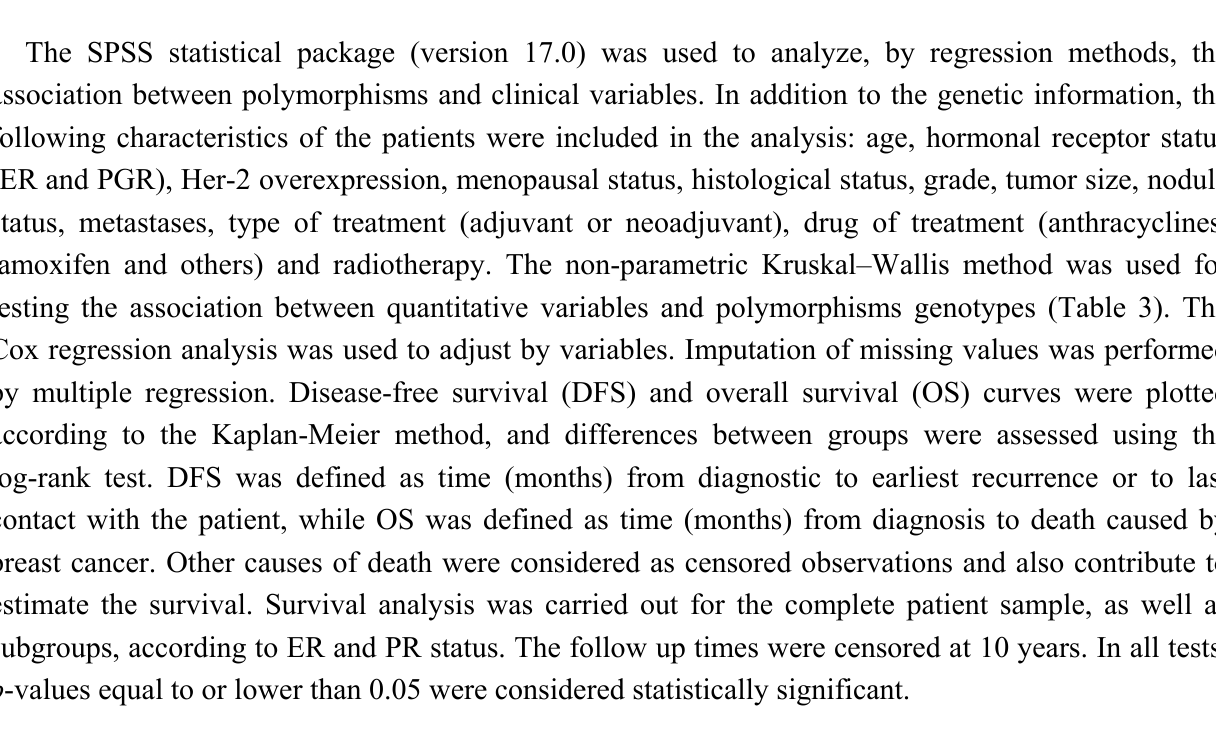
Table 3. Kruskal–Wallis test of association for rs1052133, r207454 and rs3736729